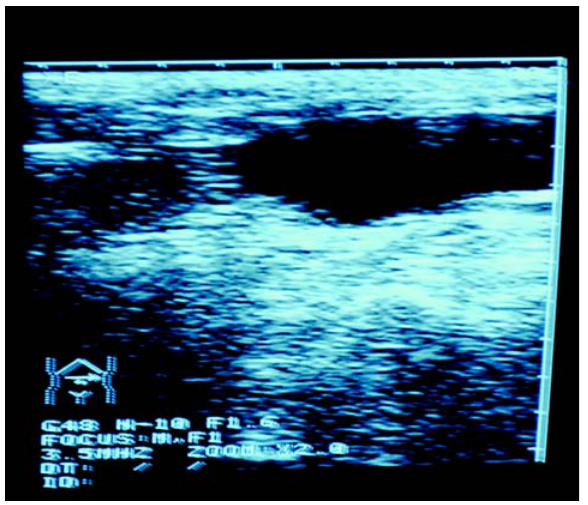
Figure 4 – Canine vesical stone, post extracorporeal